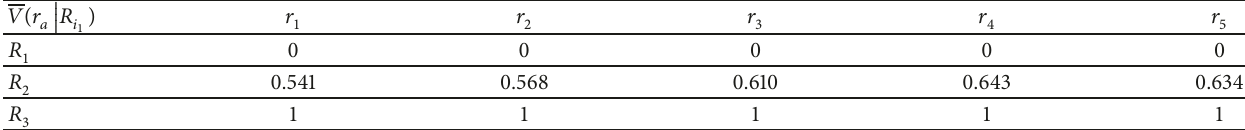
Table 8: The standardization for the prospect value of